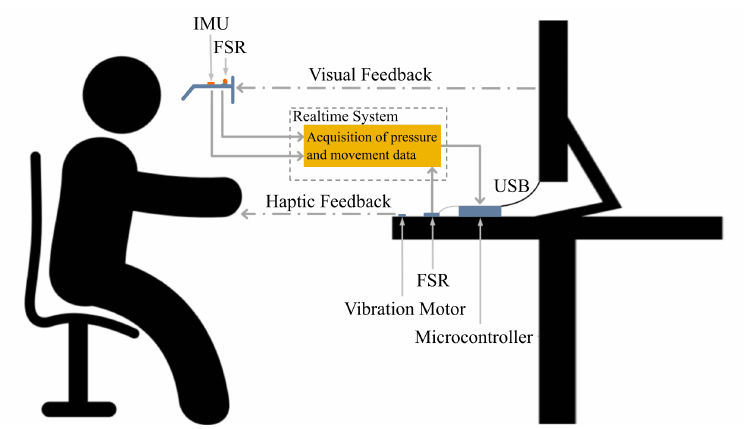
Figure 1. Concept of the alternative mouse and keyboard interface, showing the connection between the components and the user. The general setup is illustrated as intended during usage. The components of the alternative interface are marked in blue.